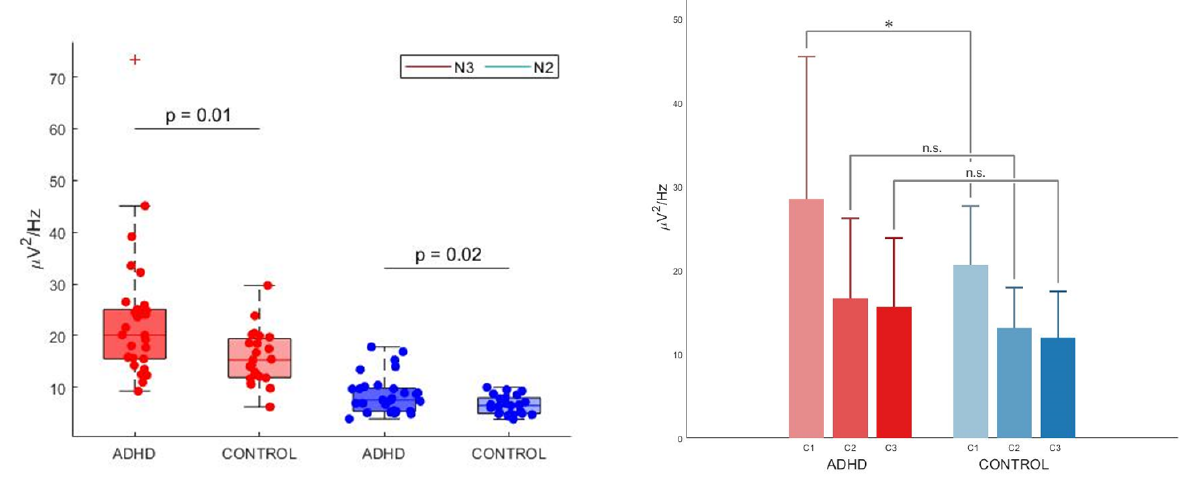
Figure 4. Left panel—Absolute spectral density averaged across channels within the significant Theta cluster in the attention-deficit/hyperactivity disorder (ADHD) and the control group in non-rapid eye movement (NREM) sleep stage 3 (N3) and NREM sleep stage 2 (N2). Red dots represent N3, blue dots N2. The bottom and top of each boxplot are the 25th and 75th percentiles of the sample, respectively. The distance between the bottom and top of each box is the interquartile range. The green line in the middle of each box is the sample median. The whiskers extending above and below each box go from the end of the interquartile range to the furthest observation within the whisker length. Observations beyond the whisker length (more than 3 times the interquartile range away from the bottom or top of the box) are marked as outliers. The cross (+) represents an outlier. The mean difference was significant between the ADHD group (N3: M = 22.90, SD = 12.65, N2: M = 8.60, SD = 3.73) and the control group (N3: M = 15.77, SD = 5.22, N2: M = 6.54, SD = 1.81) for both N3 ( p < 0.05, also after the removal of the outlier in the ADHD group, Cohen’s d = 0.70, meaning a medium effect size, independent samples t -test) and in N2 ( p = 0.018, Cohen’s d = 0.68, meaning a medium effect size, independent samples t -test). There was a significant interaction effect ( p < 0.05) between stages (N3 versus N2) and groups (ADHD versus control) at a mixed between-within ANOVA model (not shown in the figure). Right panel—Absolute spectral density averaged across channels within the significant Theta cluster in the attention-deficit/hyperactivity disorder (ADHD) and the control group in different sleep cycles (first, second and third cycle). X-axes: time expressed in cycles, Y-axes: average power values in selected frequency range of 3–10 Hz, expressed in µ V/Hz 2 . Red bars: ADHD group. Blue bars: control group. C1: first cycle, C2: second cycle; C3: third cycle. There was a significant difference in 3–10 Hz power of the significant cluster of channels for the ADHD group (M = 28.55, SD = 16.97) and the control group (M = 20.63, SD = 7.06) in N3 of the first sleep cycle: t(51) = 2.10, ADHD > controls, p < 0.05, Cohen’s d = 0.61, meaning a medium effect